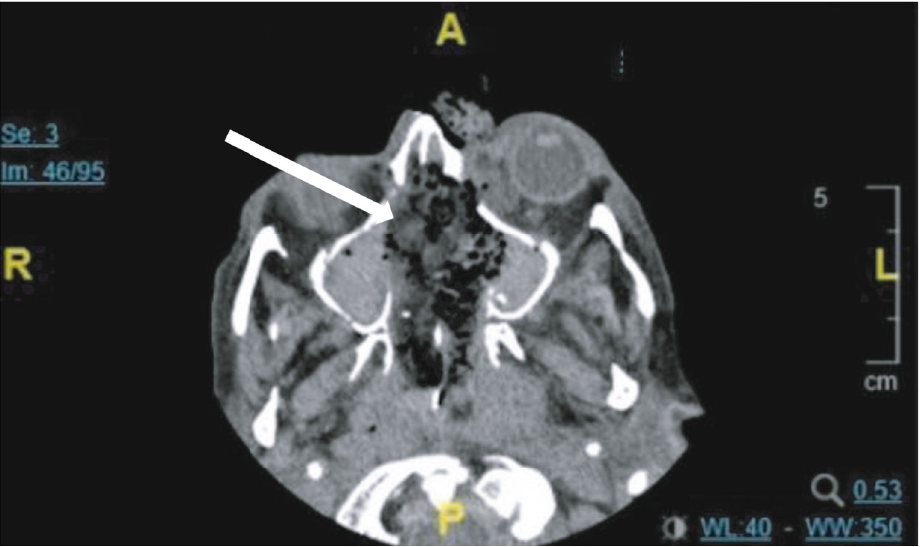
Figure 3: Patient 3 MRI image mucromycosis growth in sinuses.